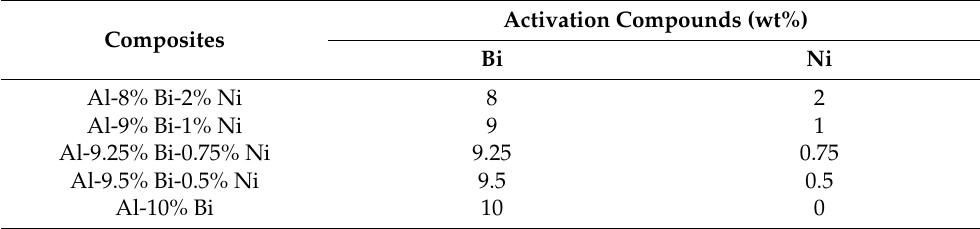
Activation Compounds (wt%) Bi Ni